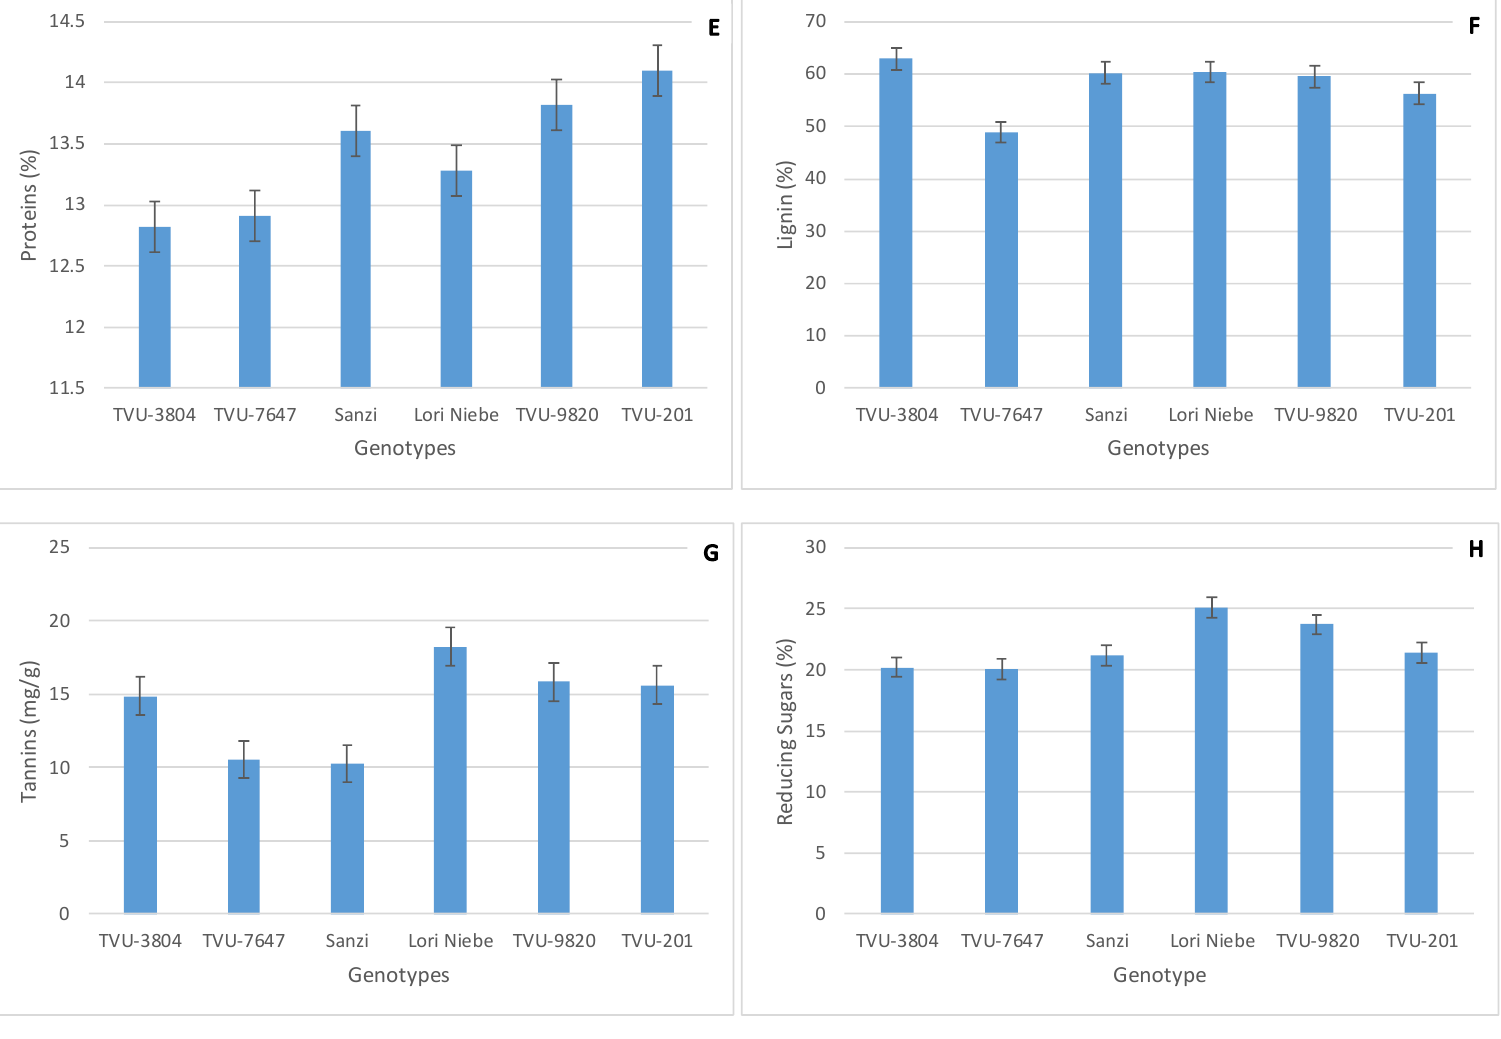
Figure 1. Means for flower thrips damage ( A ), flavonoids ( B ), antioxidants ( C ), phenolics ( D ), proteins ( E ), lignin ( F ), tannins ( G ) and reducing sugars ( H ) on Cowpea evaluated across 4